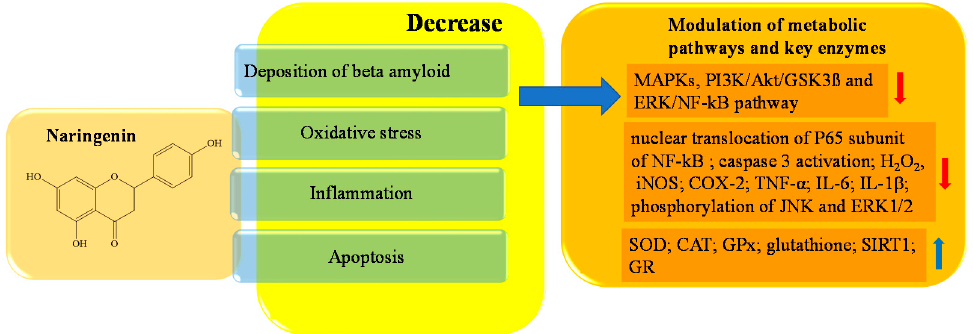
Figure 5. Schematic effects of naringenin on molecular targets of AD. Epigallocatechin-3-gallate (EGCG), an ester of epigallocatechin and gallic acid, is the main bioactive polyphenol found in solid green tea extract [141,142]. EGCG has been reported to bypass the blood–brain barrier (BBB) and exert potent neuroprotective properties against AD, in a wide range of cell models [143]. Several works have shown that EGCG (5-15 mg/kg) reduces the accumulation of β amyloid able to interfere with the formation of β -sheets, the process involved in amyloid formation cascade [144,145]. EGCG promotes the non-amyloidogenic process by promoting α secretase cleavage and inhibiting β and γ secretase, by way of suppression of the ERK/NFkB pathway [146,147]. Sonawane et al. demonstrated the EGCG’s potential for dissolving pre-formed Tau filaments and oligomers in a time- and concentration-dependent manner; the IC50 for Tau aggregation by EGCG was found to be 64.2 µ M [148]. Ehrnhoefer et al. have demonstrated that EGCG can convert mature A β fibrils into smaller forms free of toxicity, redirecting polypeptide aggregation into off-pathway protein assemblies [145]. In APP-C99-overexpressed cultured MC65 cells, EGCG (5–20 µ M) is also able to suppress A β -induced neurotoxicity through GSK3 β activation and inhibition of c-Abl/FE65 nuclear translocation [149]. In addition, it attenuates oxidative stress and mitochondrial impairment, and restores intracellular antioxidant levels in different neuronal cell lines and AD models [150]. More specifically, in EOC 13.31 microglial cell lines, EGCG (5–20 µ M) suppresses the expression of TNF α , iNOS, IL-1 β , and IL-6, and it inhibits the activation of the NF-K β and MAPK signal, but increases the synthesis of GSH. Chi et al. demonstrated significant pro- tection of EGCG (22.5–90 μ M) against oxidative damage caused by H 2 O 2 to chicken lym- phocytes. After preincubation with EGCG, the compound restored H 2 O 2 ′ s harmful effects, suppressing the increase of ROS and restoring the antioxidant system by mRNA expres- sion of SOD, CAT, and GPx [151]. EGCG enhances cholinergic neurotransmission through inhibition of AChE and BChE. ACh content was significantly elevated in a dose-depend- ent manner, which ultimately led to an improvement in the learning and memory function of AD rats [152]. In Figure 6 a schematic representation of the main activity of epigallocat- echin-3-gallate is depicted. Figure 6. Schematic effects of epigallocatechin-3-gallate on molecular targets of AD.